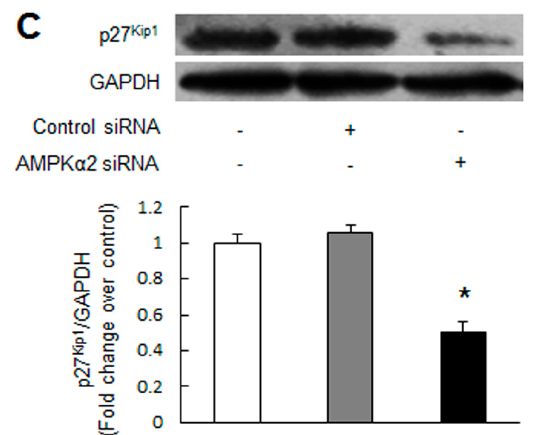
Figure 2. Knockdown of AMPK α 2 increases the phosphorylation of mammalian target of rapamycin (mTOR), upregulates S-phase kinase-associated protein 2 (Skp2) and downregulates p27 Kip1 . Primary cultured PASMCs were transfected with AMPK α 2 specific siRNA and non-targeting siRNA. Phosphorylation of mTOR ( A ) and protein levels of Skp2 ( B ) and p27 Kip1 ( C ) were determined by immunoblotting ( n = 3 in each group). +, with indicated siRNA transfection; − , without siRNA transfection; * p < 0.01 versus control.